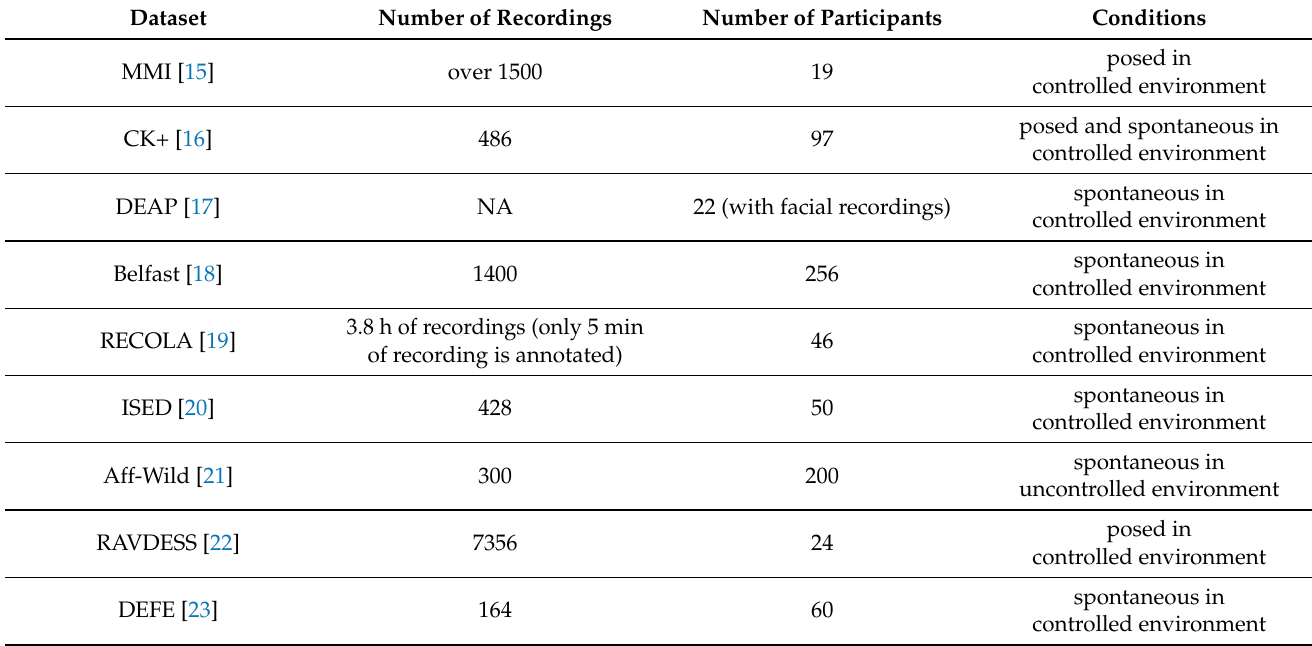
Table 1. List of datasets with video recordings of facial expressions of